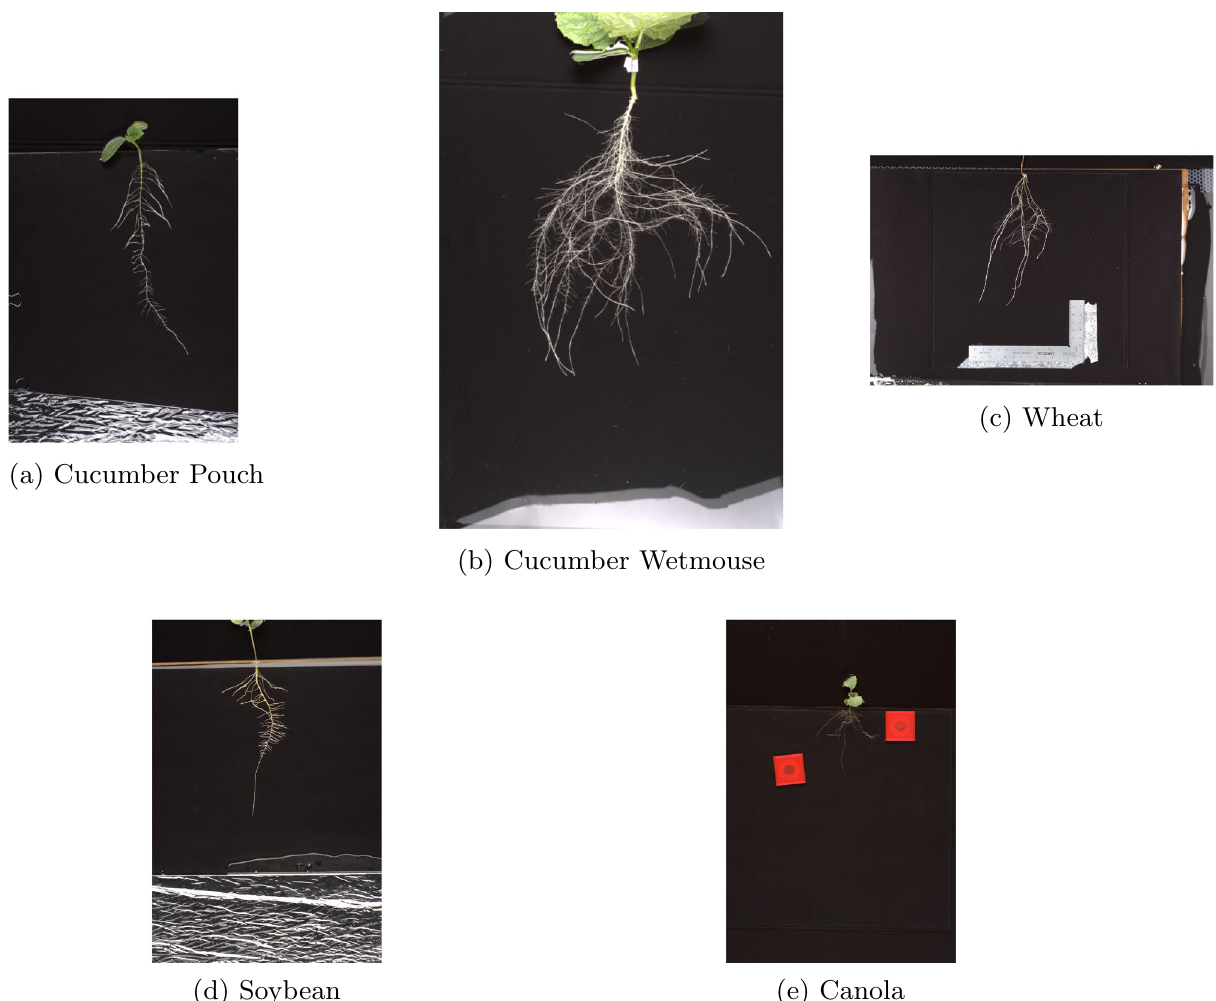
Figure 4. Example images from the Cucumber-Pouch ( a ), Cucumber-Wetmouse ( b ), Wheat ( c ), Soybean ( d ), and Canola ( e ) data